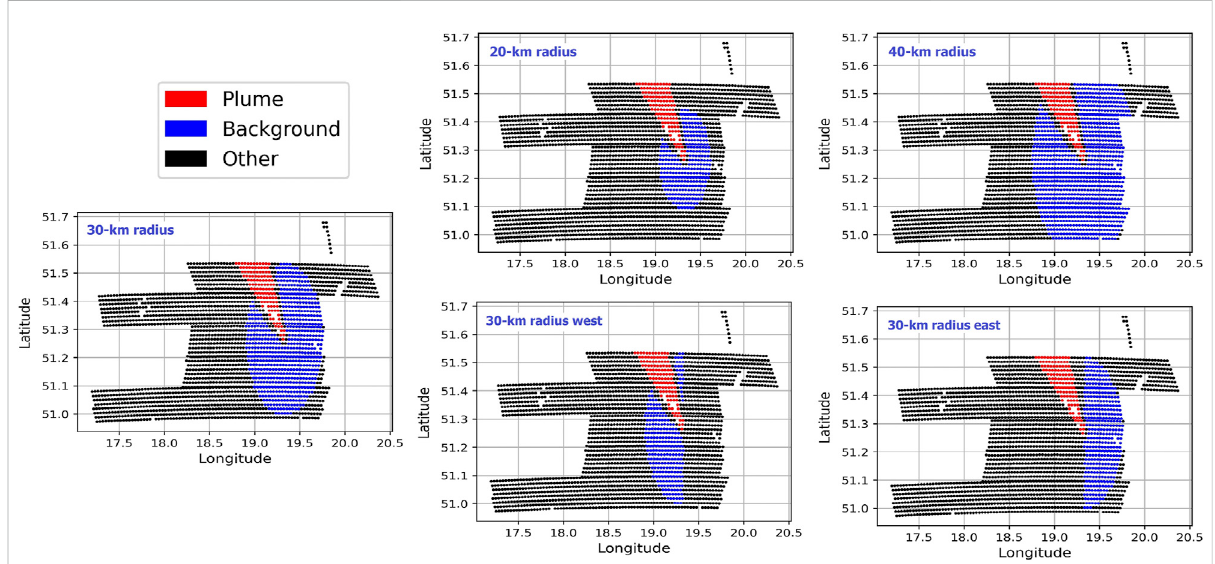
FIGURE 3 Background XCO 2 for OCO-3 emission estimates is determined as the average XCO 2 within a 30-km radius excluding the plume sector and a narrow buffer region (left). The background uncertainty is determined as the higher uncertainty that results from one of two ensembles: 1) A varying radiusensembleof20,30,and40 kmradii(uppercentreandright)and2)thefull30-kmradiusalongwiththeeasternandwesternhalvesofthesame radius (lower centre and